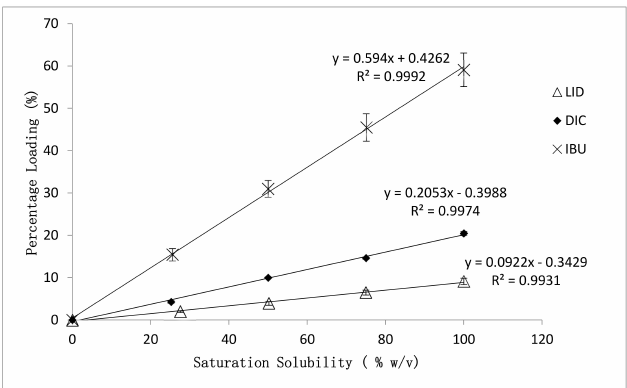
Figure 1. Effect of drug physicochemical properties on the percentage loading of post-loaded hydrogels. Error bars represented the standard deviation ( n = 6) of